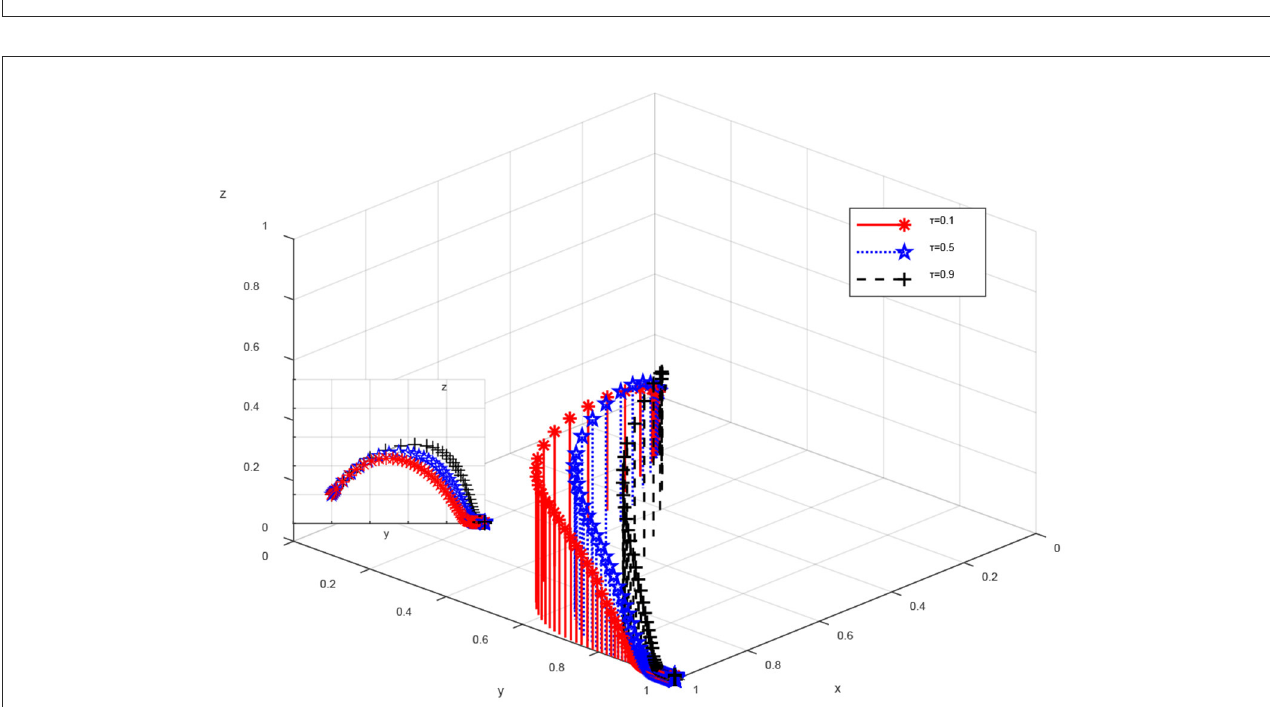
FIGURE6 Impact of the fineness of waste